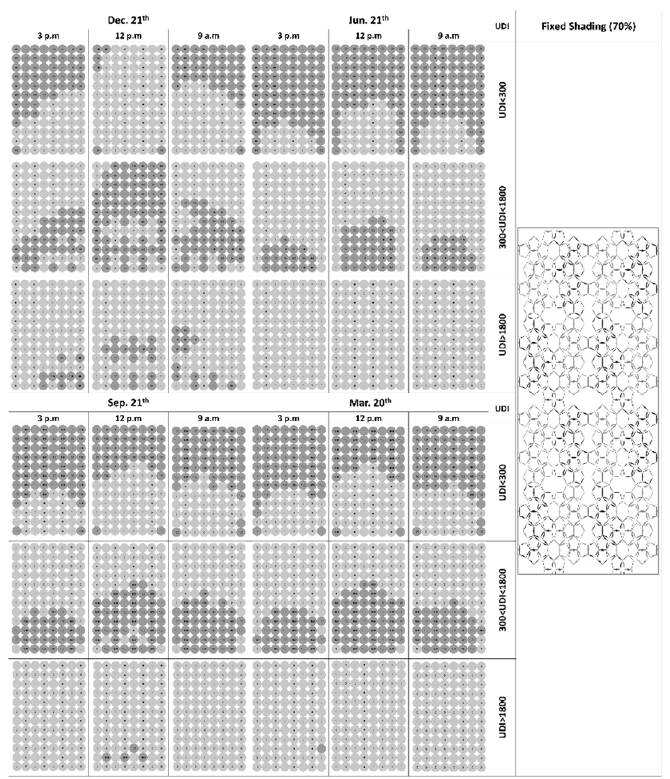
Figure 12. Useful Daylight Illuminance of critical days in the model with shading device type 2.